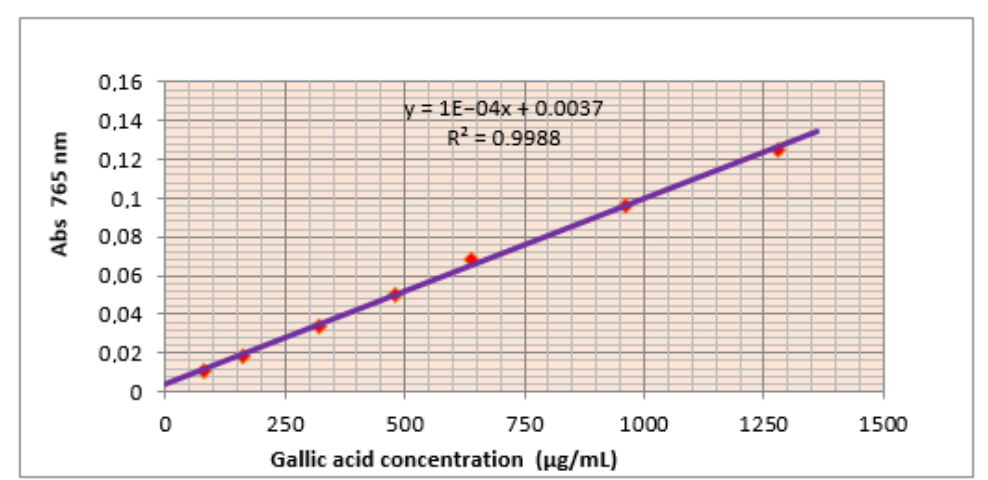
Figure 1. Gallic acid calibration curve used for total phenol quantification.